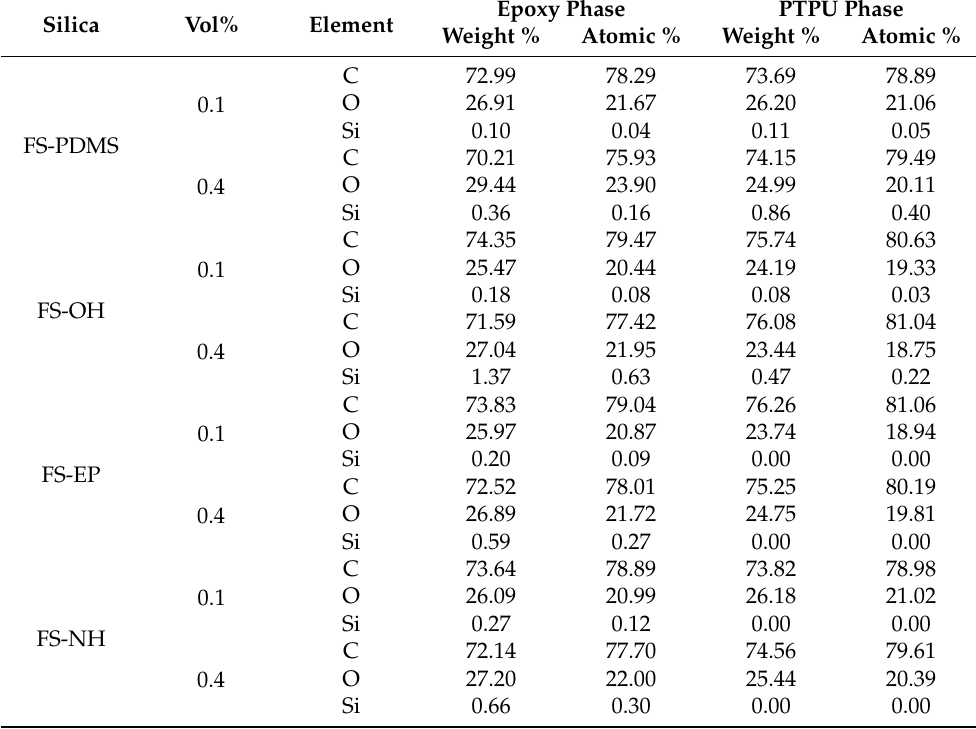
Table 4. EDS results of the fracture surface of silica-modified epoxy